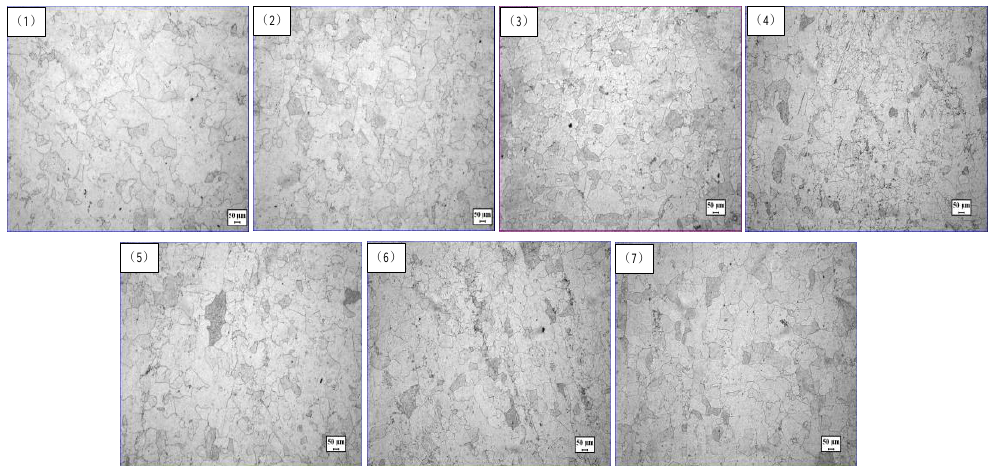
Figure 7. The equilibrium diagram of tensile specimen before deformation. ( 1 ) is correspondence with